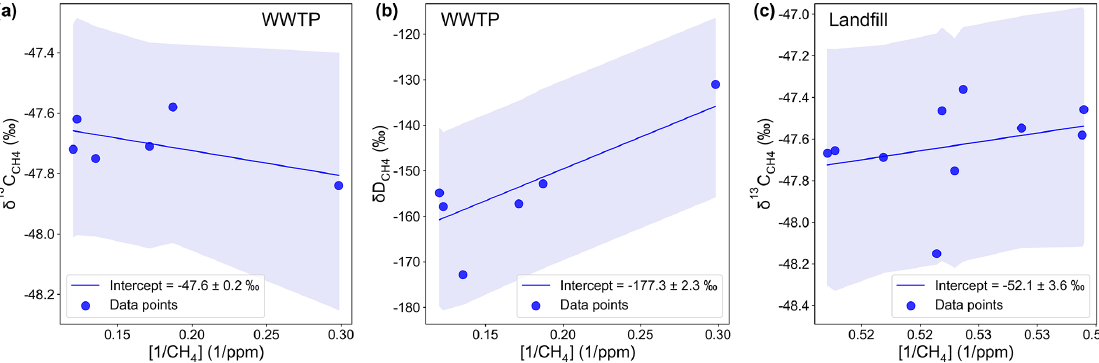
Figure A7. Keeling plots of all data from the WWTP and landfill analysed using Bayesian linear regression. Panels (a) ( δ 13 C) and (b) ( δ D) show the results for WWTP and panel (c) ( δ 13 C) shows the result for landfill.